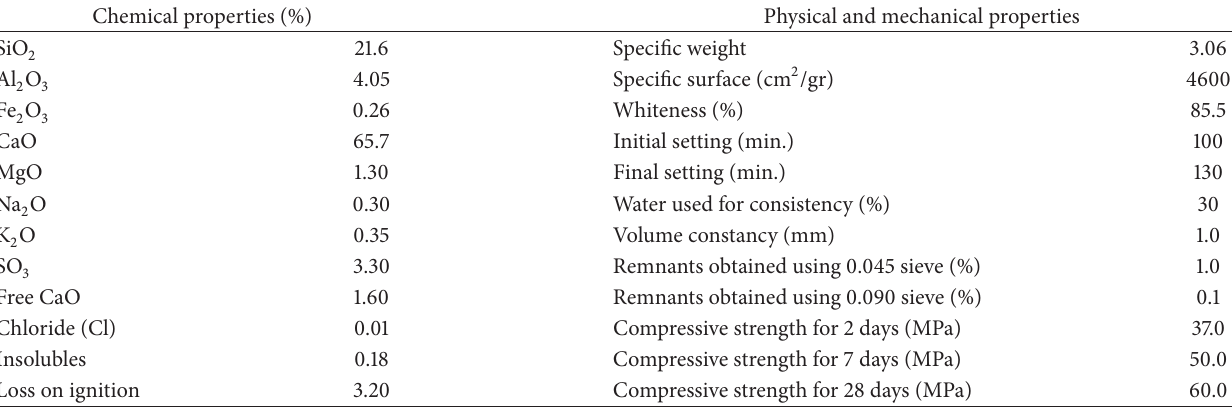
Table 1: The chemical and physical properties of CEM I 52.5 R cement.